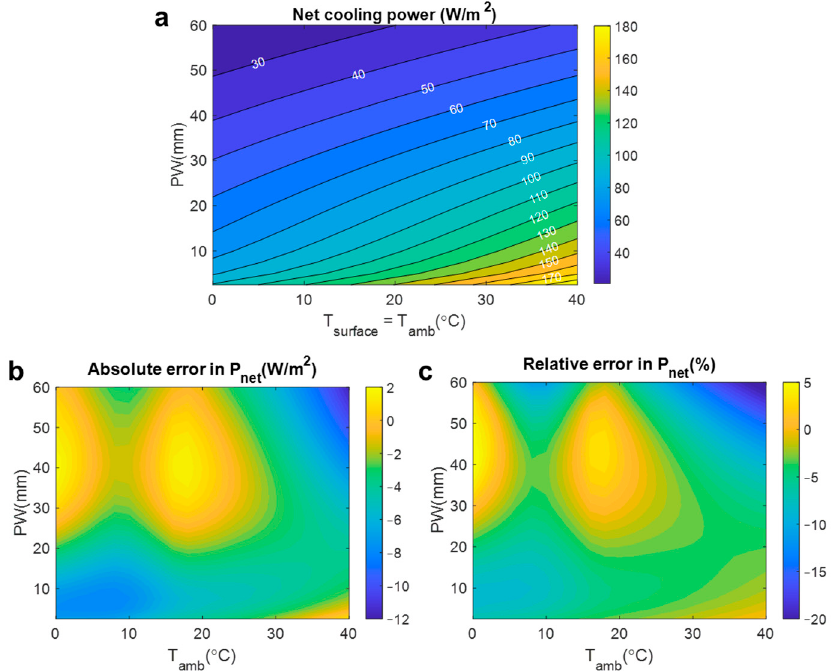
Figure 4. Net cooling power an “ideal black” radiative cooler. ( a ) Net cooling power was obtained with the simplified approach. The contour lines show values of the net cooling power in W/m 2 . Here, the atmospheric downward radiation was calculated based on T amb and the zenith-0 ◦ atmospheric emissivity in the normal direction. ( b ) Absolute and ( c ) relative errors in the net cooling power from the simplified approach. Positive and negative signs are retained to highlight underestimation and overestimation. The mid-latitude summer spectrums in Figure 3 were used to compute the cooling